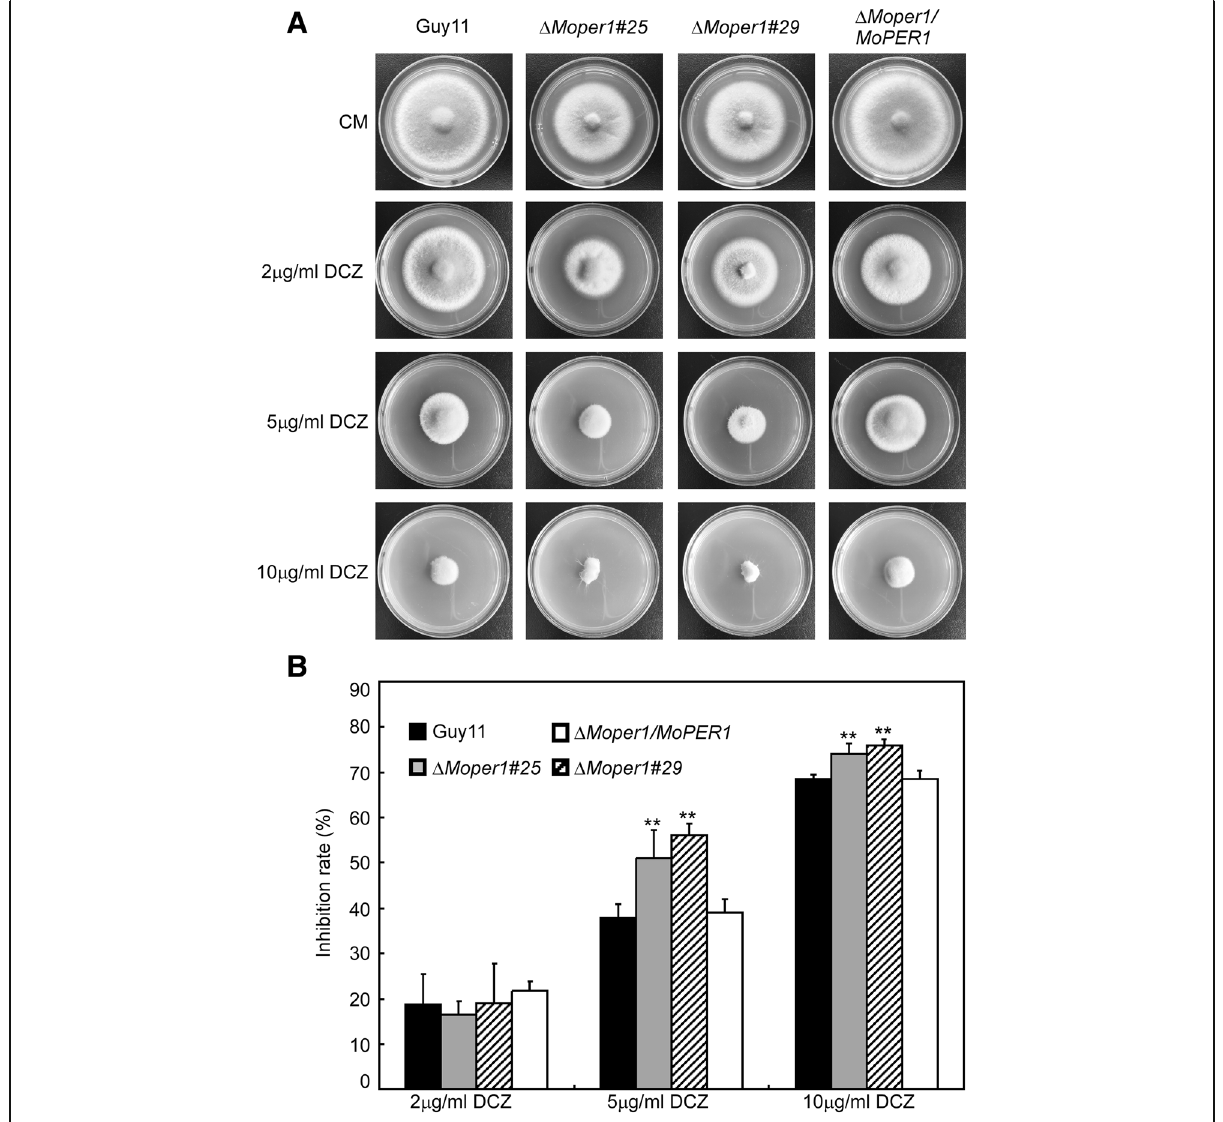
Fig. 4 Δ Moper1 mutants increased susceptibility to the antifungal triazole drug, difenoconazole (DCZ). a The wild type strain Guy11 and the Δ Moper1 strain were inoculated on CM medium with or without DCZ (2, 5 and 10 μ g/ml), and cultured at 28 °C for 7 days. b The growth inhibition rate is estimated relative to the growth rate of each untreated control [Inhibition rate = (the diameter of untreated strain – the diameter of treated strain)/(the diameter of untreated strain × 100%)]. Three repeats were performed and similar results